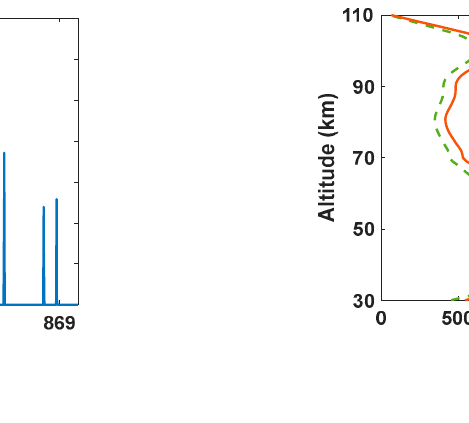
Figure 3. The spectral and VER profile characteristics of O 2 (0-1) dayglow. ( a ) The spectral character- istics of the O 2 (0-1) dayglow with the wavelength range of 865 nm to 869 nm at 60 km. ( b ) The VER profile of the emission lines at 866.65 nm and 866.30 nm. The red line and the green line in Figure 3a are the 866.15nm and the 866.30nm emission line respectively, corresponding to the Figure3b.